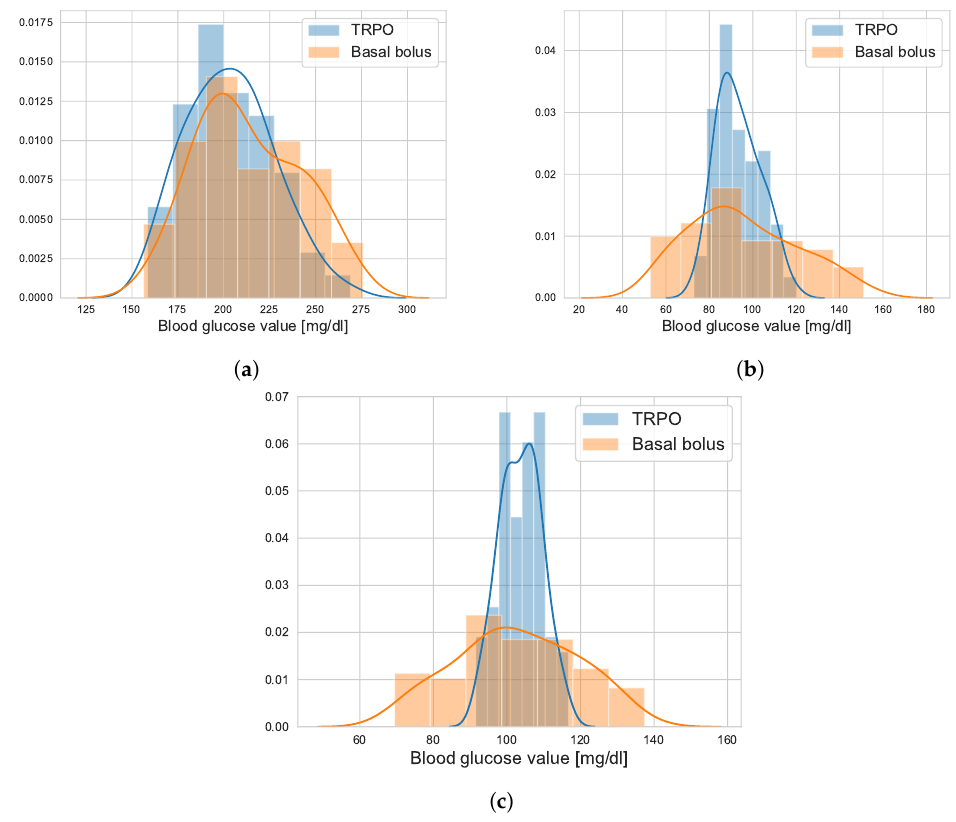
Figure 5. Kernel density estimation plot comparing the distribution of the results when comparing basal-bolus control to the TRPO agent. ( a ) shortly after a large carbohydrate intake, ( b ) between meals, ( c ) during nighttime (close to steady